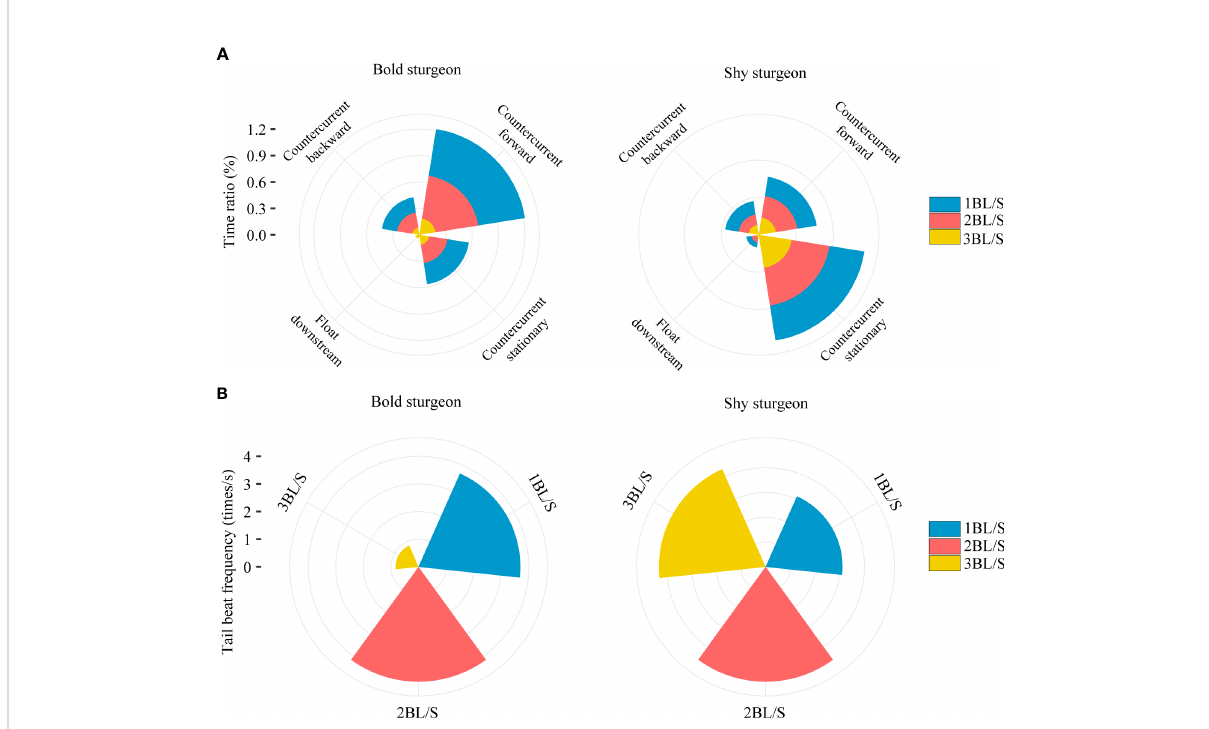
FIGURE 6 Changes in the proportion of time spent in swimming state and the tail beat frequency with different personalities. Blue, red and yellow represented 1BL/s fl ow rate, 2BL/s fl ow rate and 3BL/s fl ow rate, respectively. (A) showed the time proportion of swimming state of sturgeon with two personalities at different fl ow velocity. (B) showed the tail beat frequency of two personalities at different fl ow velocity.